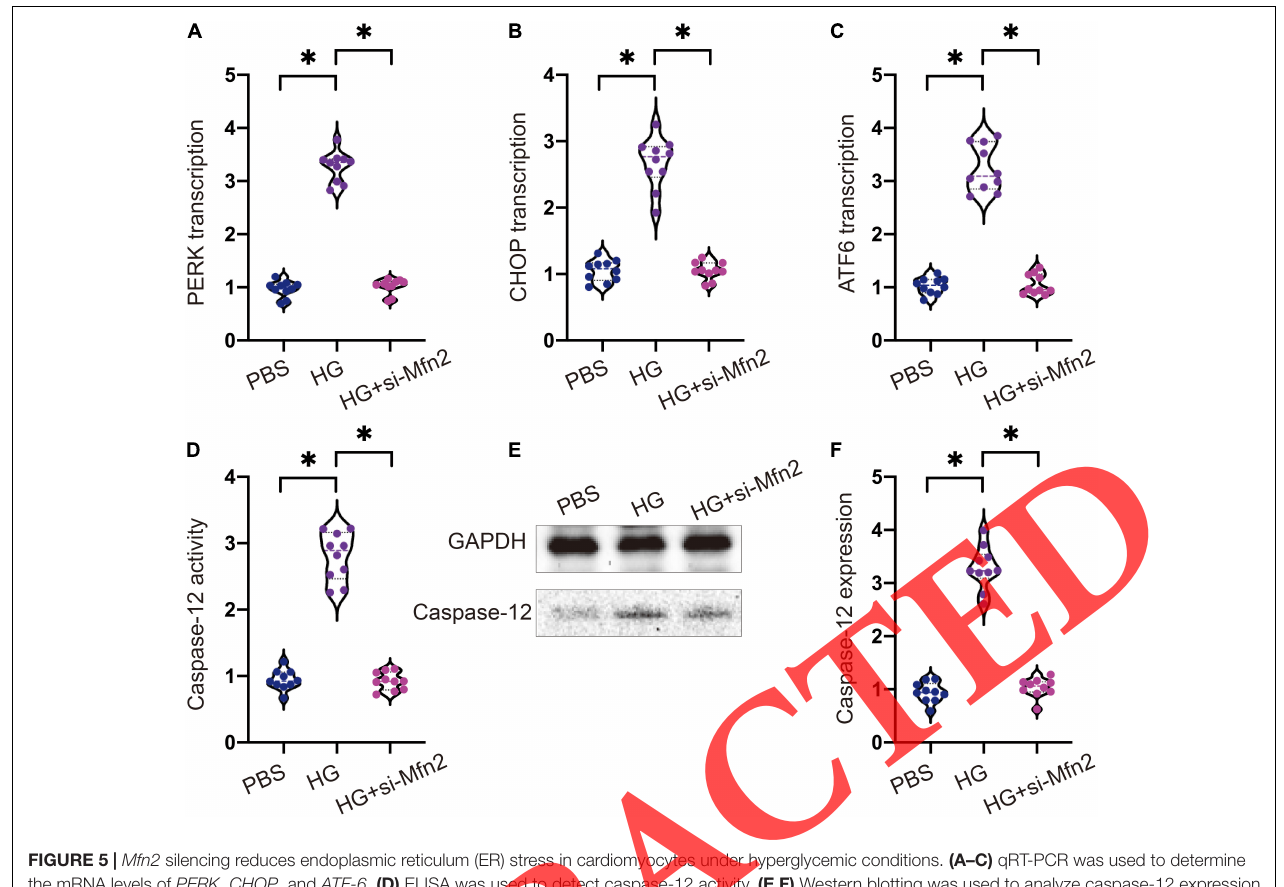
FIGURE 5 | Mfn2 silencing reduces endoplasmic reticulum (ER) stress in cardiomyocytes under hyperglycemic conditions. (A–C) qRT-PCR was used to determine the mRNA levels of PERK , CHOP , and ATF-6 . (D) ELISA was used to detect caspase-12 activity. (E,F) Western blotting was used to analyze caspase-12 expression in hyperglycemia-treated cardiomyocytes. ∗ p <